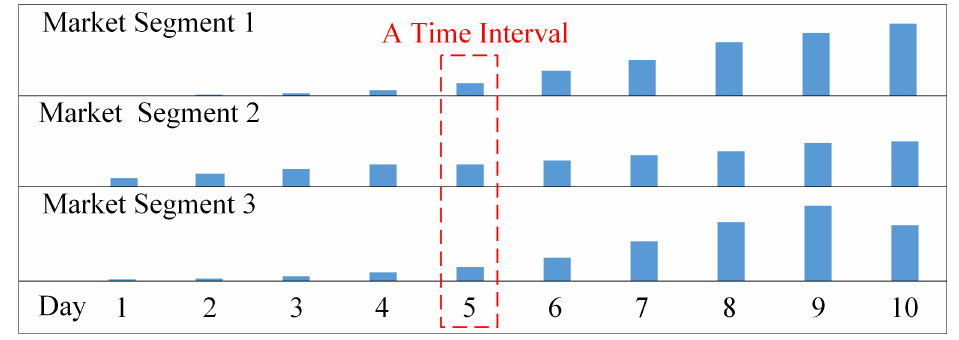
Fig 5. An example of daily passenger arrival